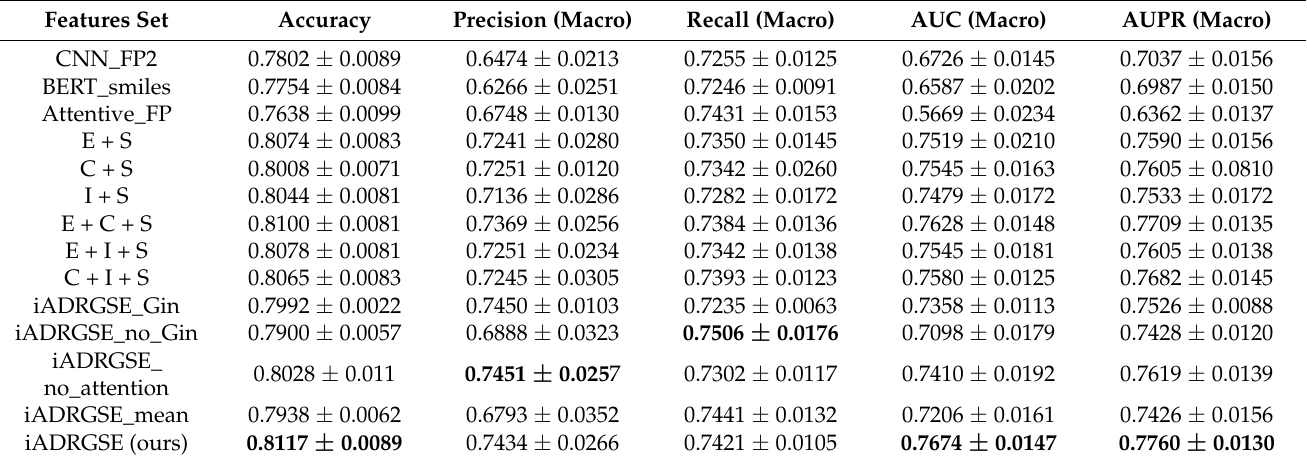
Table 1. Results for different combinations of baseline, iADRGSE, and iADRGSE